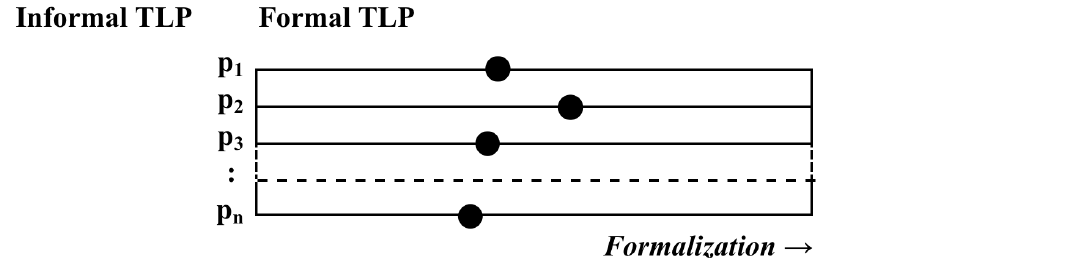
Figure 3. Sub-continua of the teaching-learning continuum with a snapshot of a possible